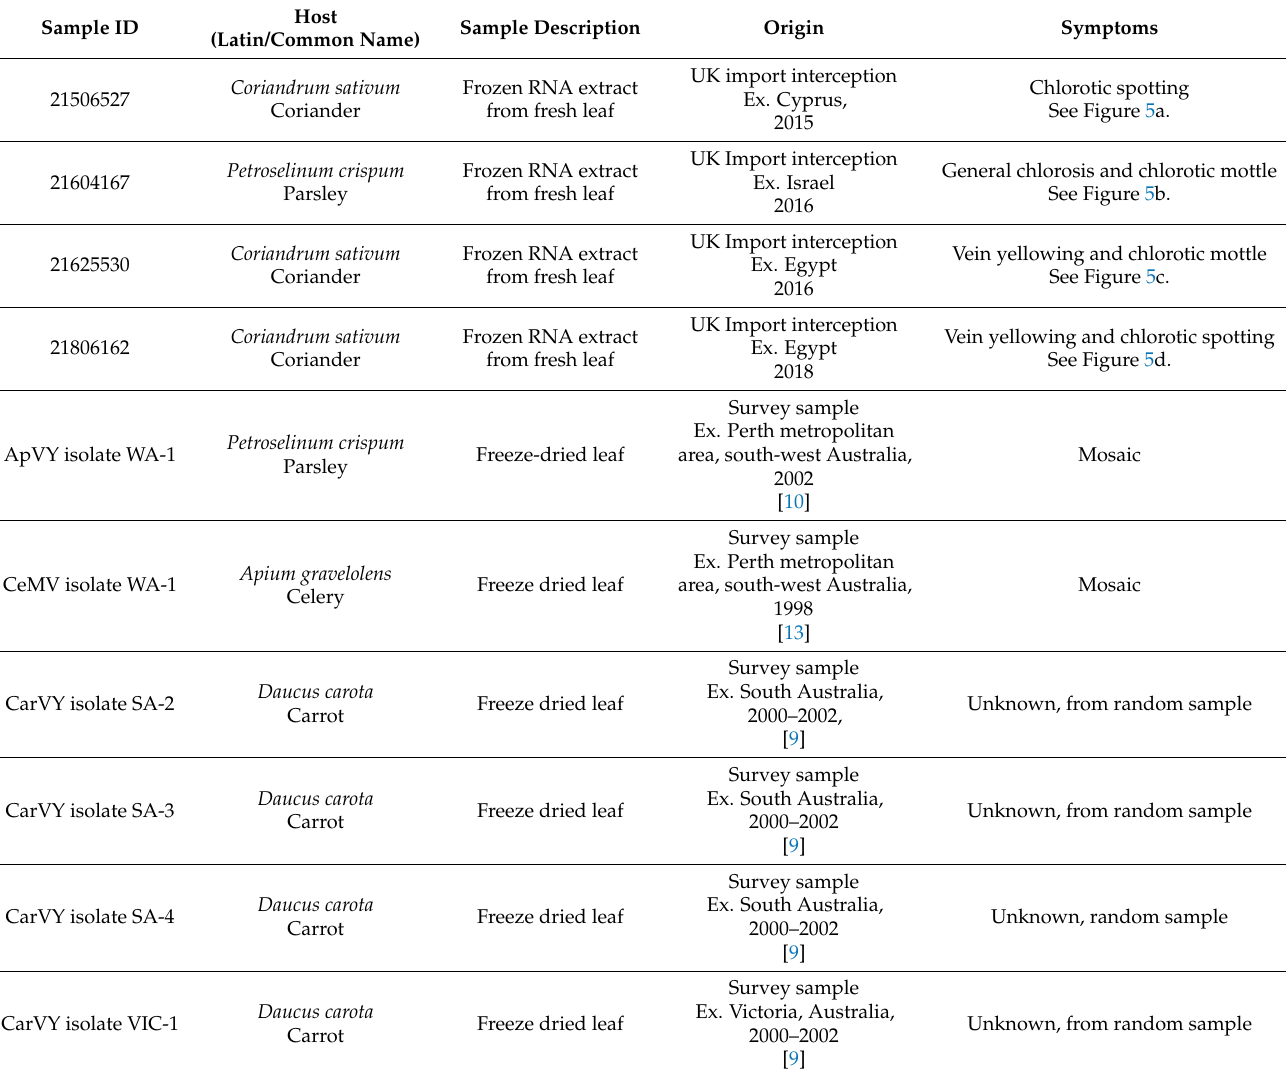
Table 2. Origin of samples and sample